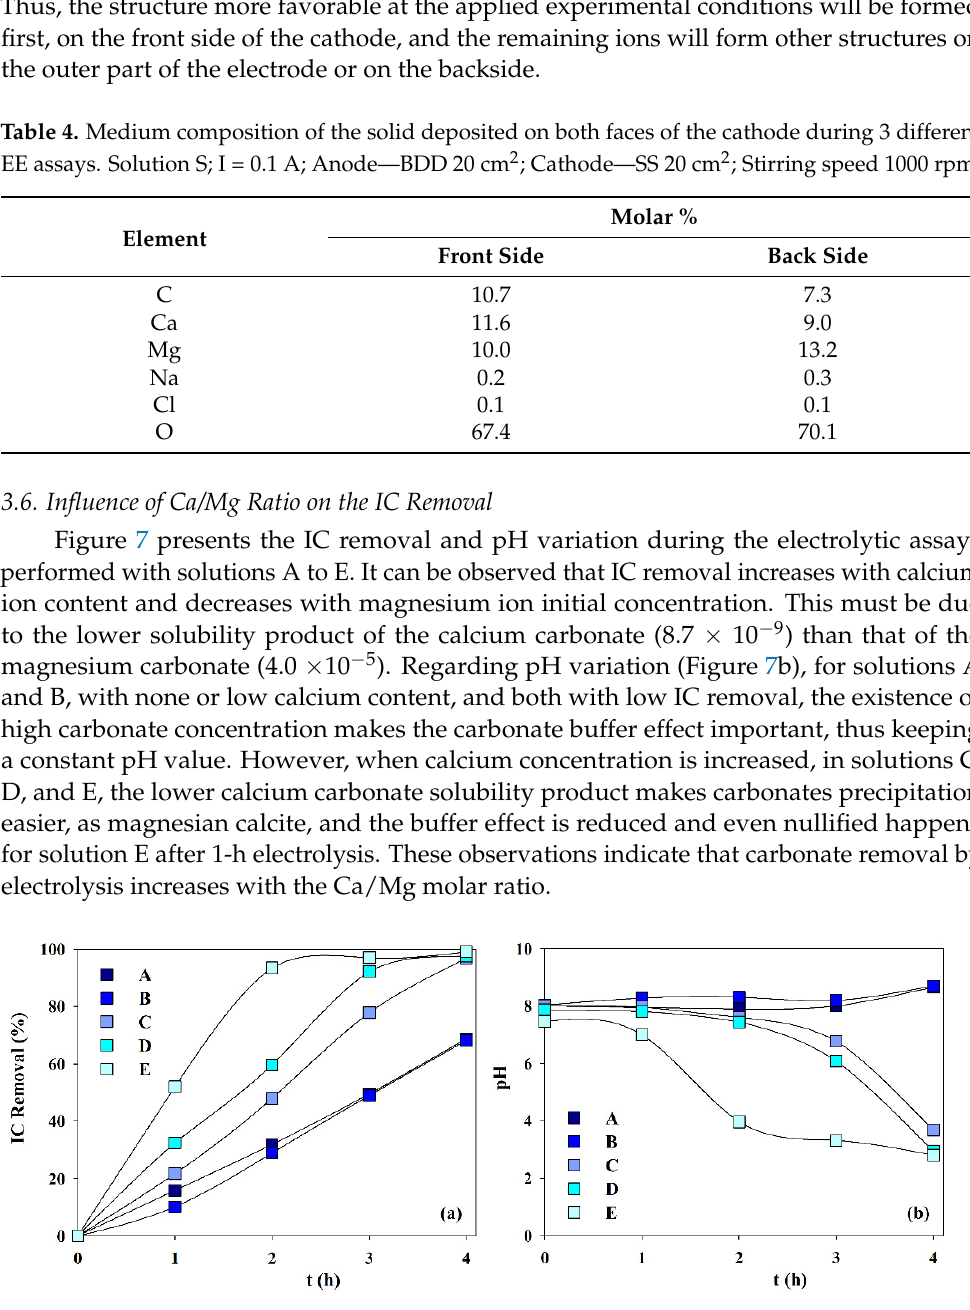
Figure 7. Effect of samples composition (Table 1) on the ( a ) inorganic carbon removal and the ( b ) pH variation during the electrochemical experiments. I = 0.3 A; SS 10 cm 2 cathode; BDD 20 cm 2 anode; volume 200 mL; stirring speed 300 rpm; 4 h.